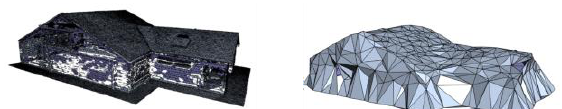
Figure 5: BPA 3D reconstruction of the detached house for the original point cloud (left) and the subsampled one (right). The detached house was processed in PolyFit (Figure 6), in its raw version – point cloud density of a point every 0.01m – and the subsamples – a point every 0.95m and every meter.